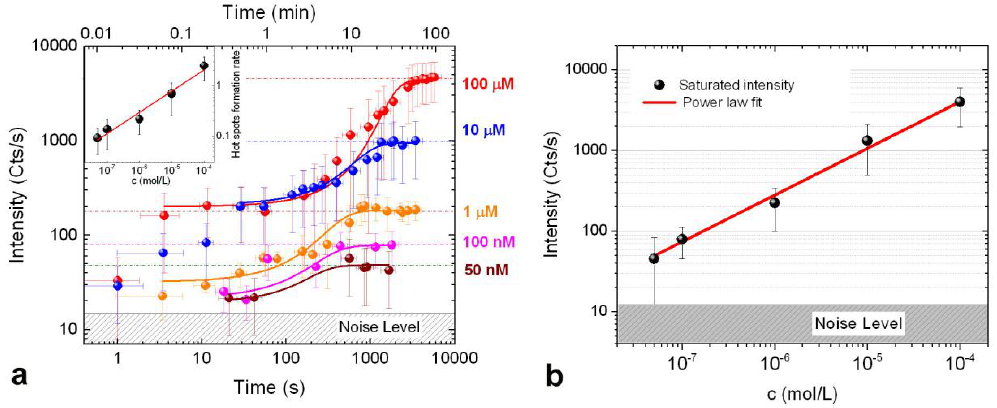
Figure 6. ( a ) Time evolution of the SERS intensity at different BSA concentrations (colored dots). The time T 0 = 0 is set at the onset of the process, when the first weak SERS signal is detected (real-time observation). Starting from T 0 the signal is recorded at intervals corresponding to the integration time used in each spectrum. Solid lines are fits of data using a Boltzmann growth kinetics equation. (inset) Plot of the maximum signal growth rate vs BSA concentration. The solid red line is a power law fit with an exponent 0.40 ± 0.04 as best fit parameter. ( b ) Plot of the SERS intensity at saturation vs. BSA concentration (symbols). The red line is a power law fit with exponent 0.60 ± 0.04.